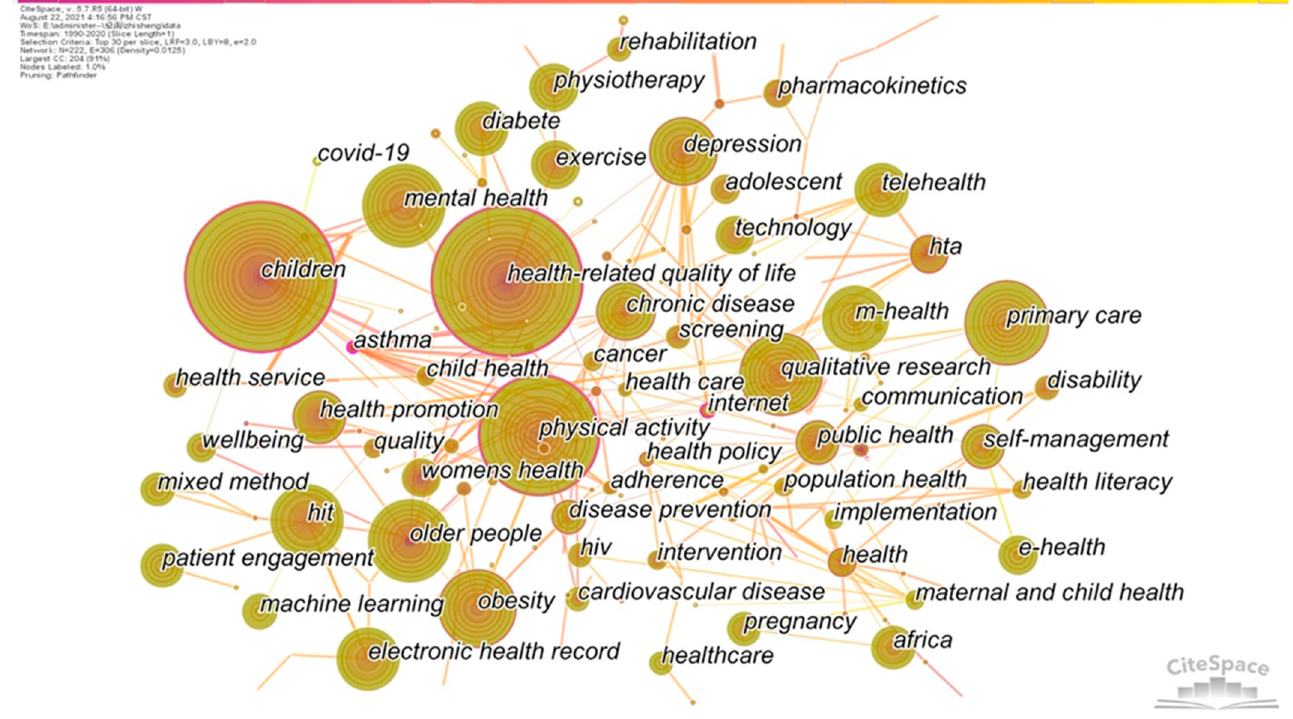
Figure 4. Keywords co-occurrence map of health technology research.